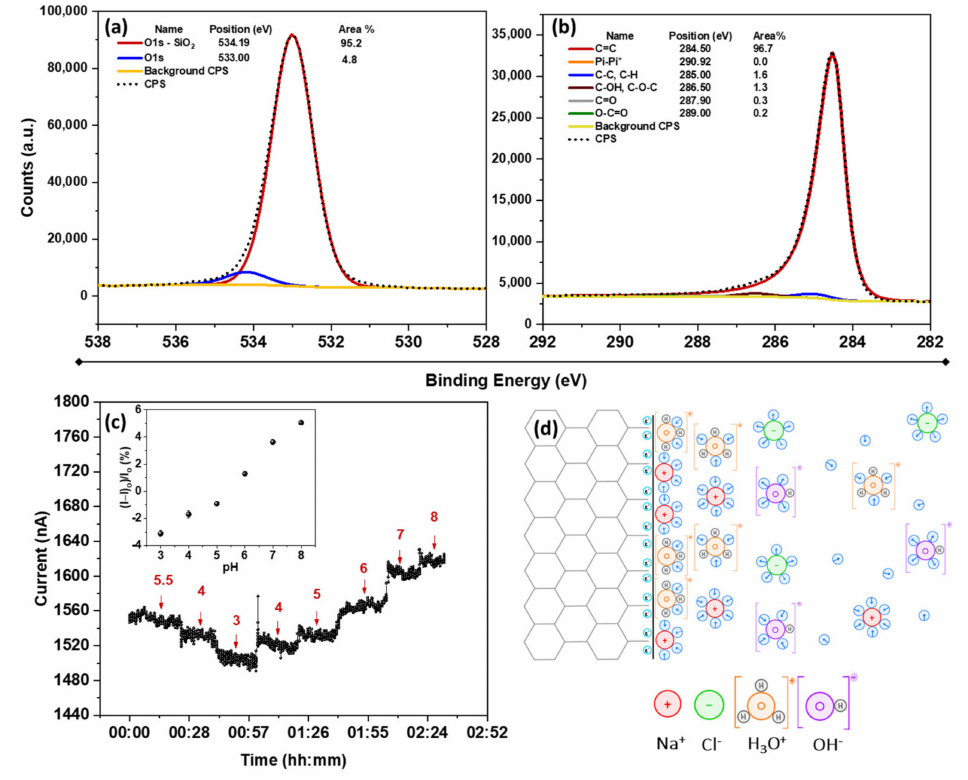
Figure 2. XPS high-resolution spectra of ( a ) O 1s and ( b ) C 1s of SLG, ( c ) pH response of SLG between pH 5.5–8 (the inset shows the corresponding calibration curve) with I o = 1524 nA, and ( d ) schematics illustration of the formation of EDL on graphene in acidic solution and its electrostatic gating